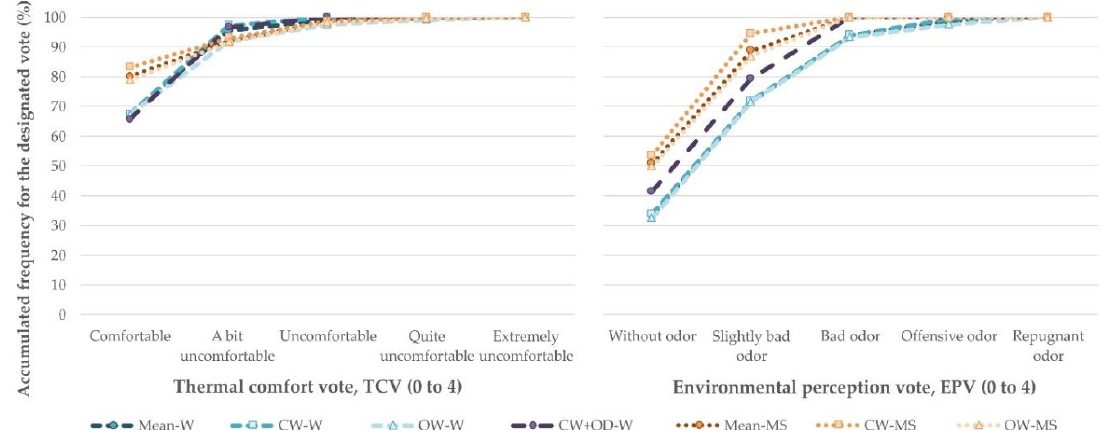
Figure 8. Accumulated frequency for the environmental perception and thermal comfort votes, related to seasons and windows’ and doors’ operation.